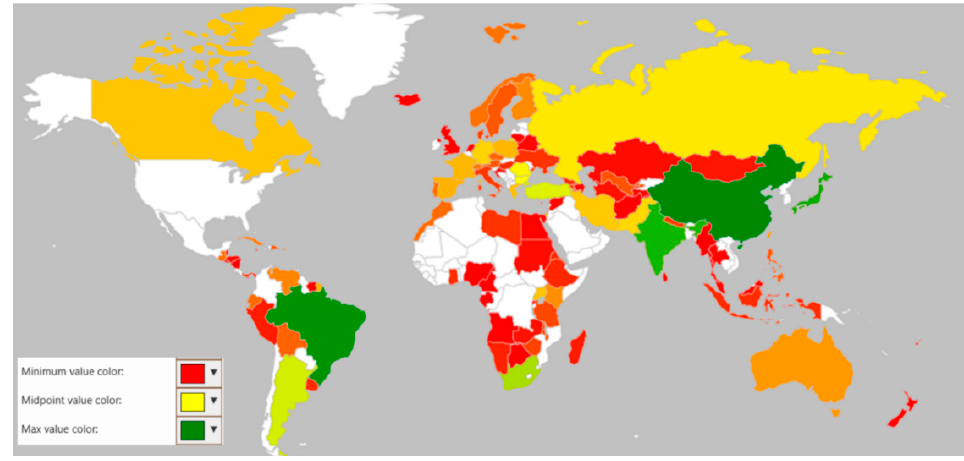
Figure 5. Heat map to show the global distribution and species richness of Uromyces spp.